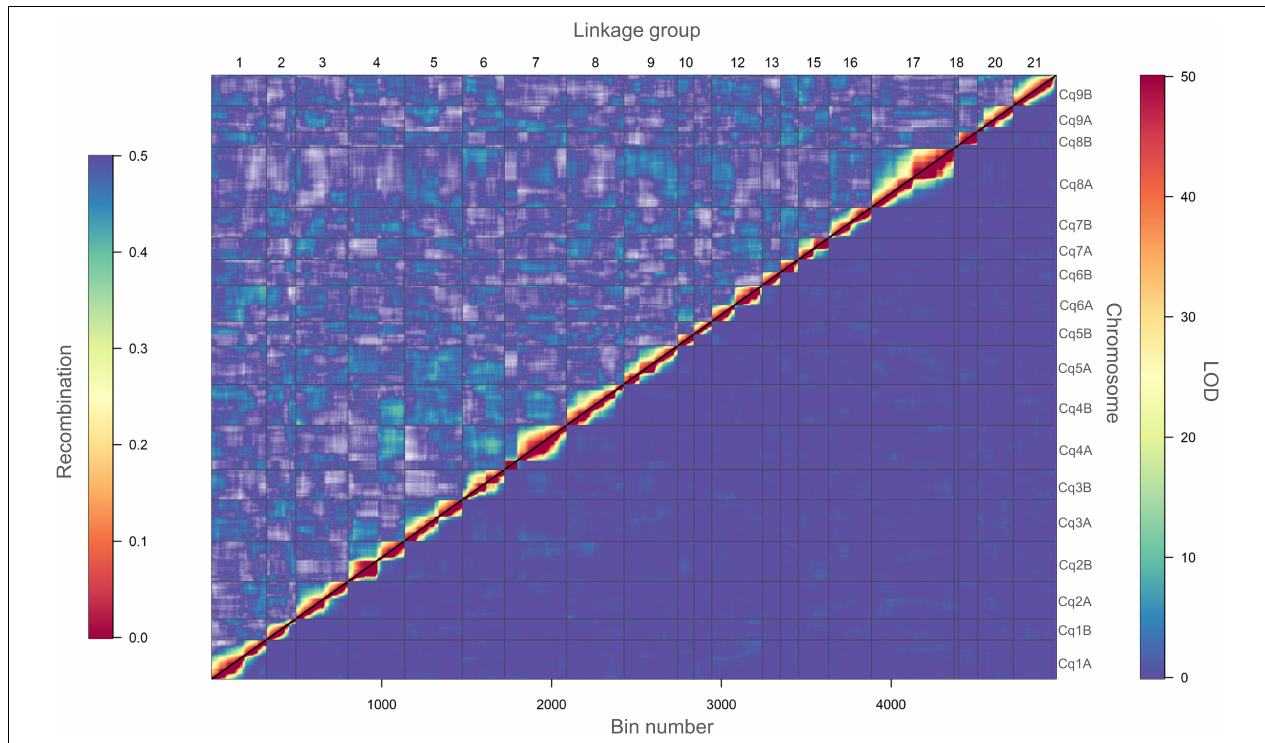
FIGURE 4 | Heatmap of pairwise recombination fractions and LOD scores based on 5,219 bins. Estimated recombination fractions between binned markers are shown above the diagonal and LOD scores below the diagonal. Red colors indicate closely linked binned markers (high LOD score and low recombination fraction), whereas, blue colors indicate non-linked binned markers (low LOD score and high recombination fraction). A LOD score of 50 corresponds to a recombination fraction of zero. Grid lines divide the binned markers by linkage groups (vertically) and by chromosomes